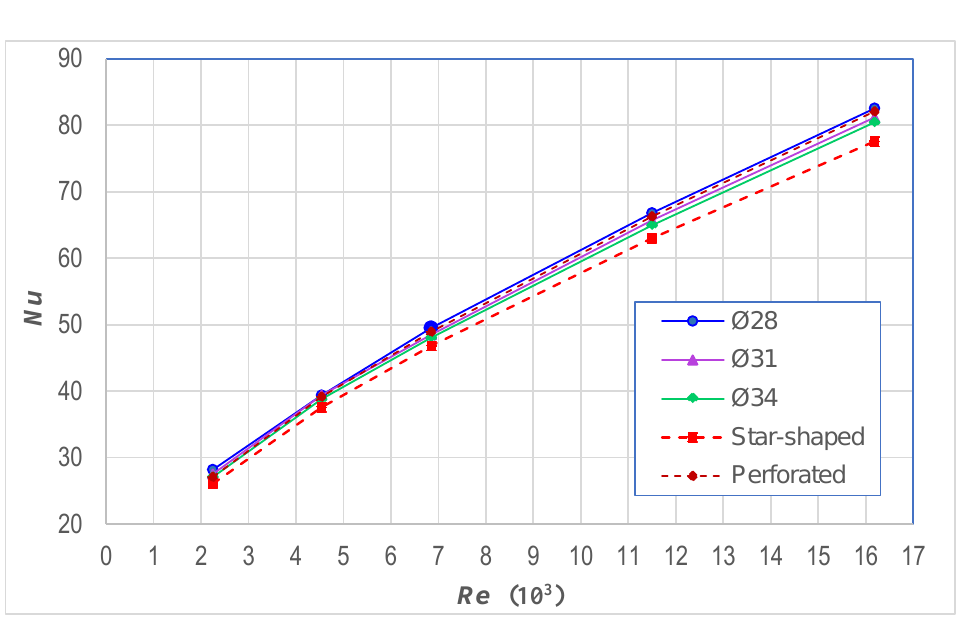
Figure 10. The y + fields for star-shaped fins and trimmed fins.